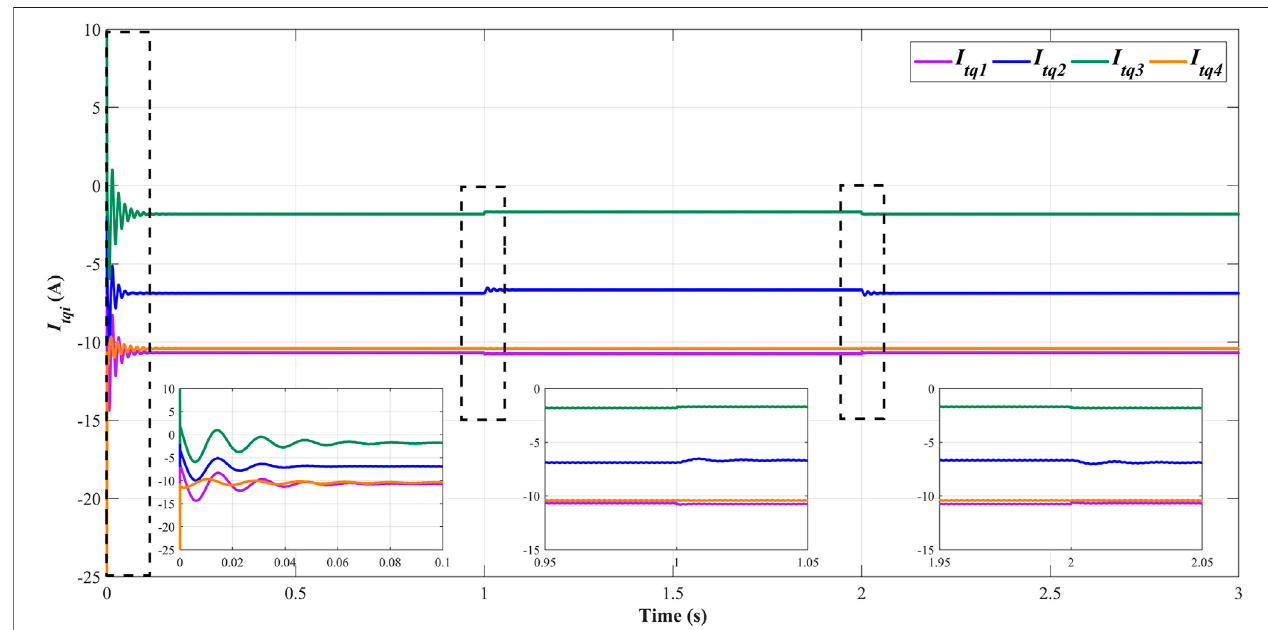
FIGURE 3 | Time evolution of the q -component of currents generated from DGus.